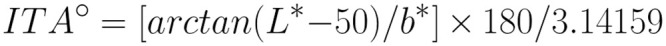
Equation used to calculate the individual typology angle using L* and b* values from the CIELAB colour space.